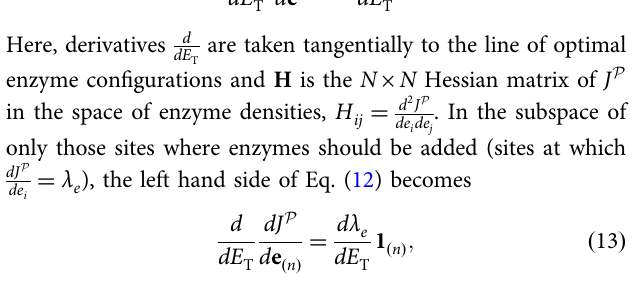
Fig. 4 Geometrical analysis of the optimal enzyme con fi guration in a system with two sites. Dashed black lines show lines of constant E = e + e T 1 2 , while dashed green lines show lines of constant reaction ; e (cid:6) J P . The optimal con fi guration e (cid:6) ¼ ð e (cid:6) Þ for each value of E T forms an 1 2 optimal trajectory e* ( E T ) (orange). Green arrows show the marginal returns vector dJ P d . The tangent vector d e (cid:6) dE (blue arrows) shows how added enzymes e T should be optimally partitioned between the